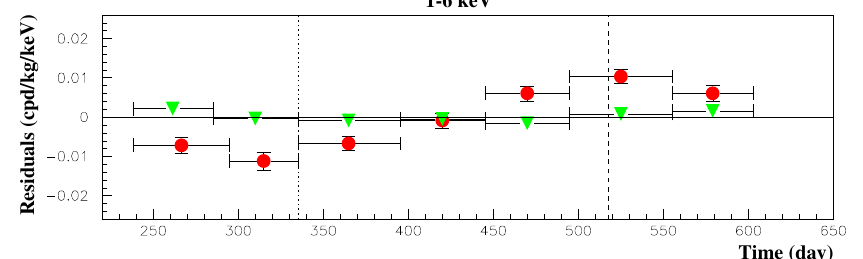
Figure 2. Experimental residual rates of DAMA/LIBRA–phase2 single-hit events (circles), class of events to which DM events belong, and for multiple-hit events (filled triangles), class of events to which DM events do not belong. For each class of events, the data were considered as collected in a single annual cycle; in both cases, the same hardware and software procedures have been applied. The time scale is the same as the previous DAMA papers for consistency. The experimental points present the errors as vertical bars and the widths of the associated time bins as horizontal bars. Analogous results were obtained for DAMA/NaI (two last annual cycles) and for DAMA/LIBRA–phase1